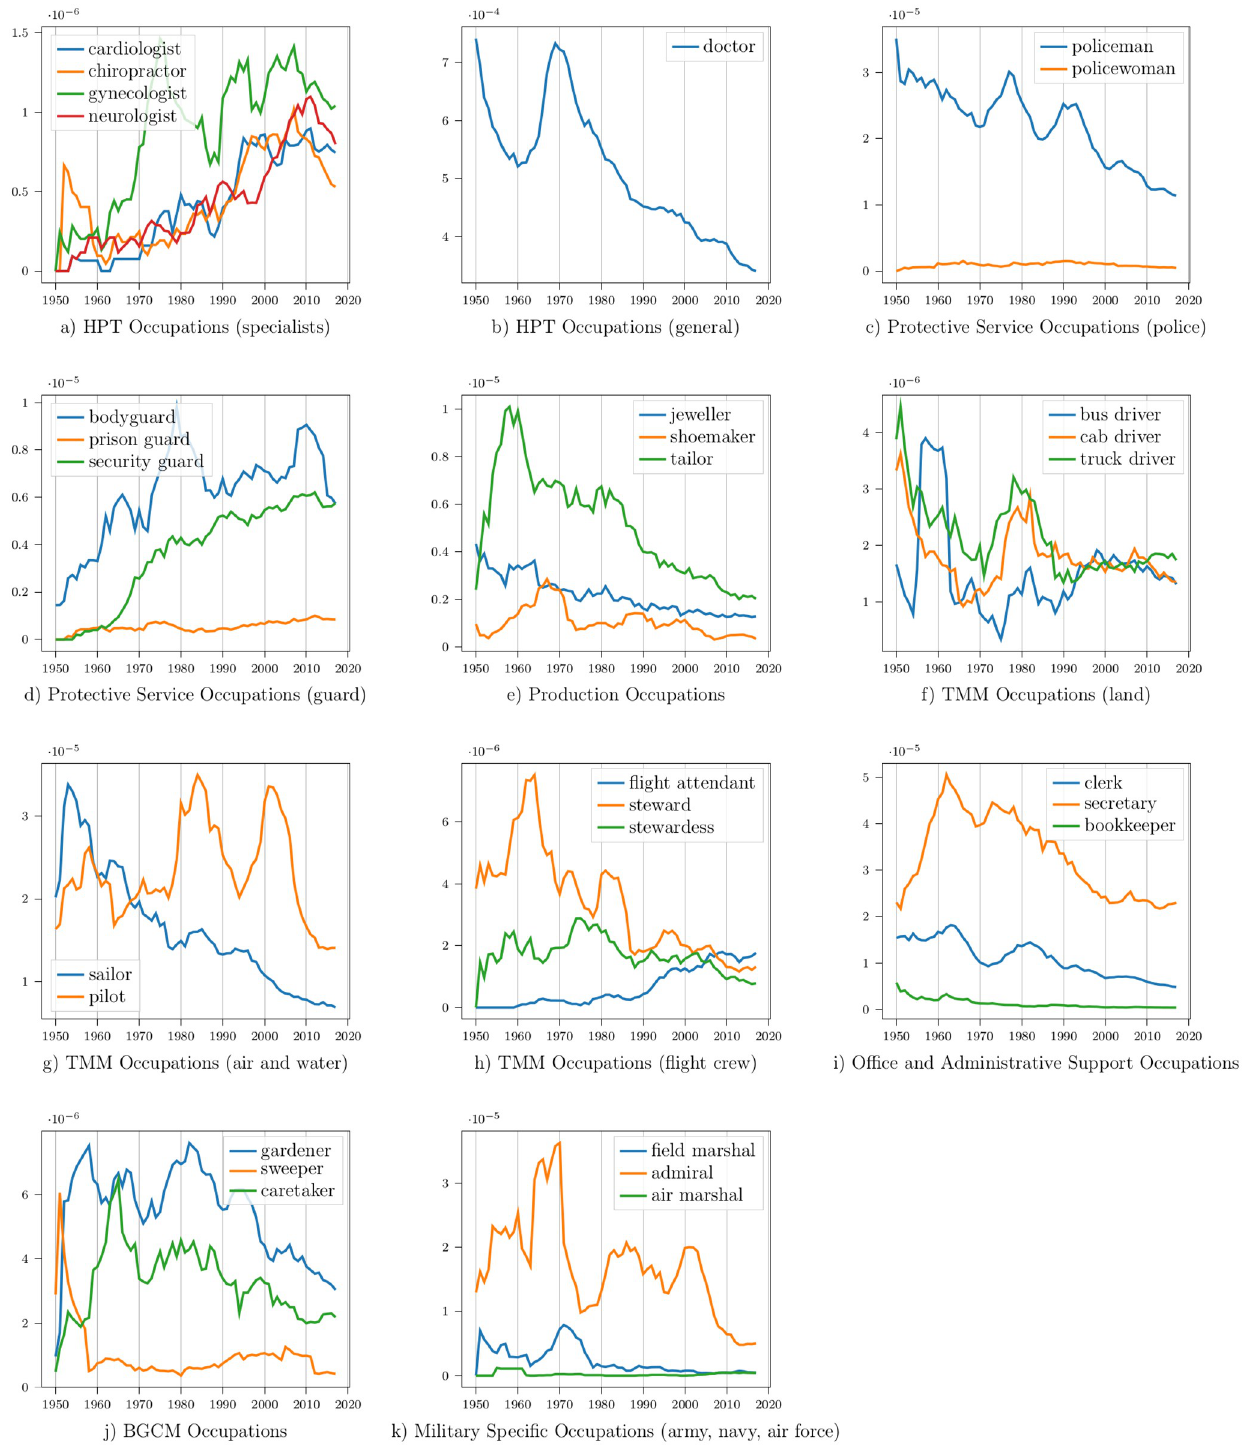
Fig 9. Frequency trends of different professions over time in media subtitles. HPT = Healthcare Practitioners and Technical. TMM = Transportation and Material Moving. BGCM = Building and Grounds Cleaning and Maintenance.